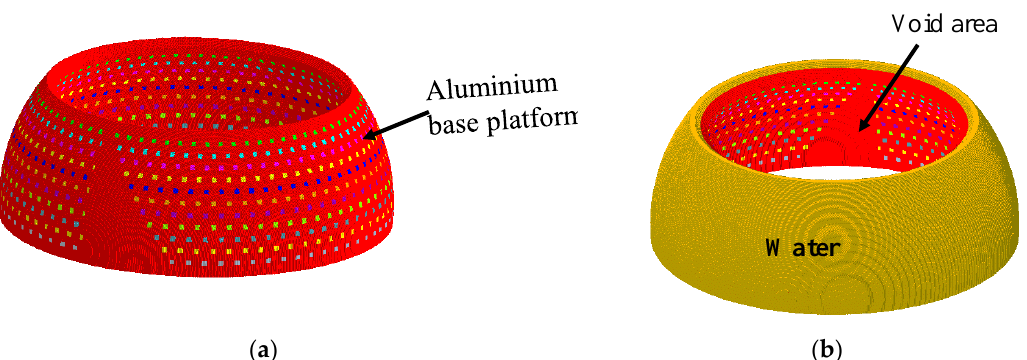
Figure 8. Finite element models of the GFA: ( a ) aluminum base platform; ( b ) array covered with a water layer.